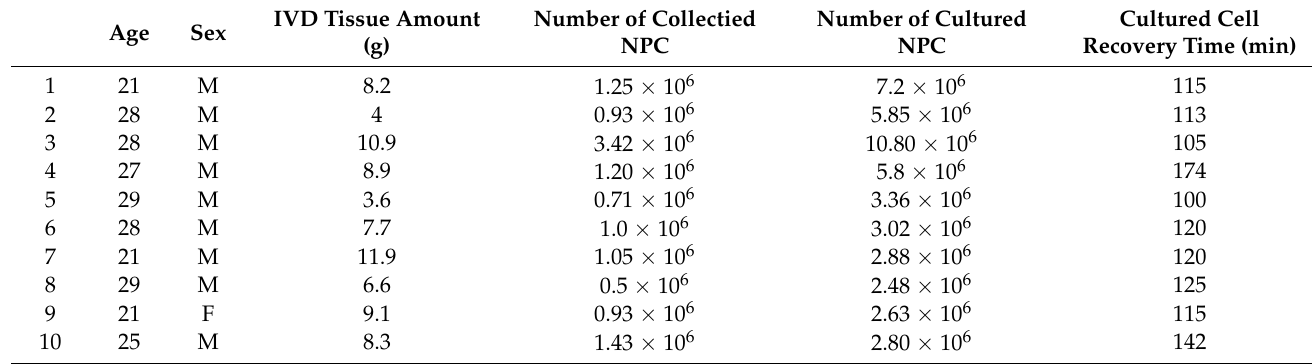
Table 3. Details of previous Mochida et al. clinical trial of autologous NP cell transplantation. In the clinical trial of Mochida et al. [16], surgically removed NP tissue and obtained cells were cultured and administered to prevent adjacent degenerative disc disease. The average time required to recover the transplanted cells was 122.9 min using a similar procedure in this study. IVD: intervertebral disc, NPC: nucleus pulposus